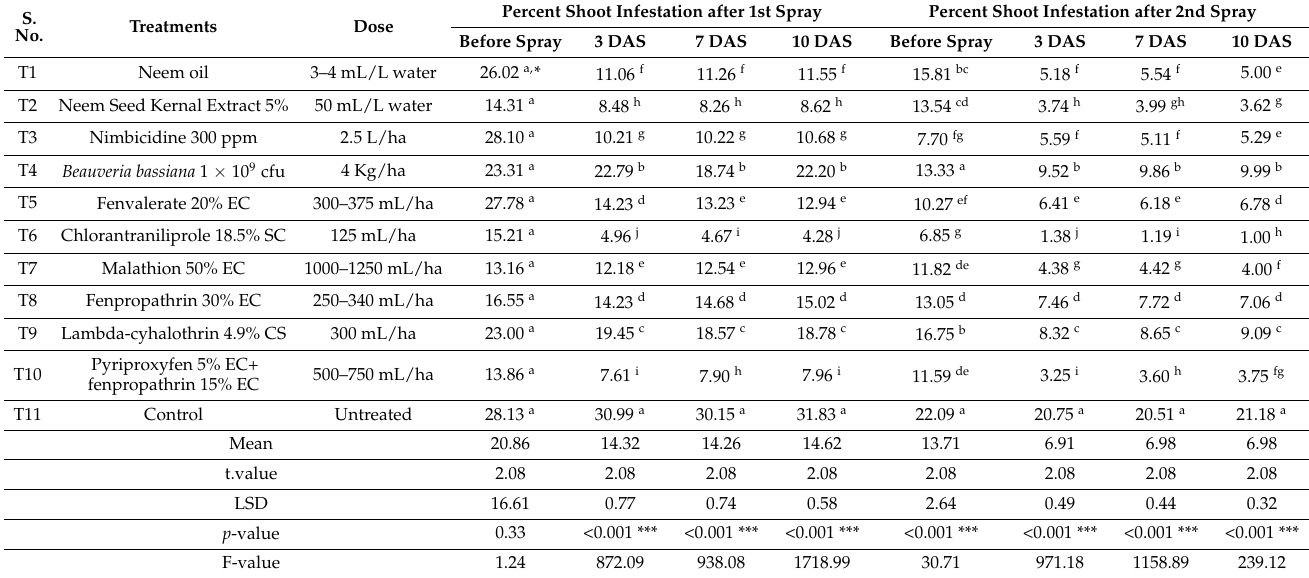
Table 1. Efficacy of 10 recommended insecticides against okra fruit and shoot borer ( Earias spp.) compared to a no insecticide control in regard to the percentage of shoot infestation following the application two sprays.